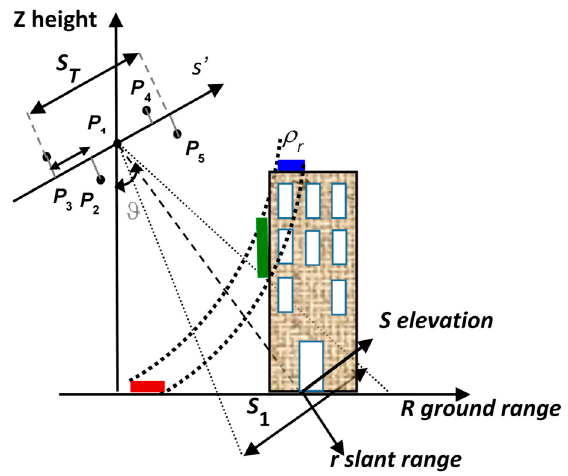
Figure 1. Multi-pass SAR geometry in the range–elevation plane (case M = 5).